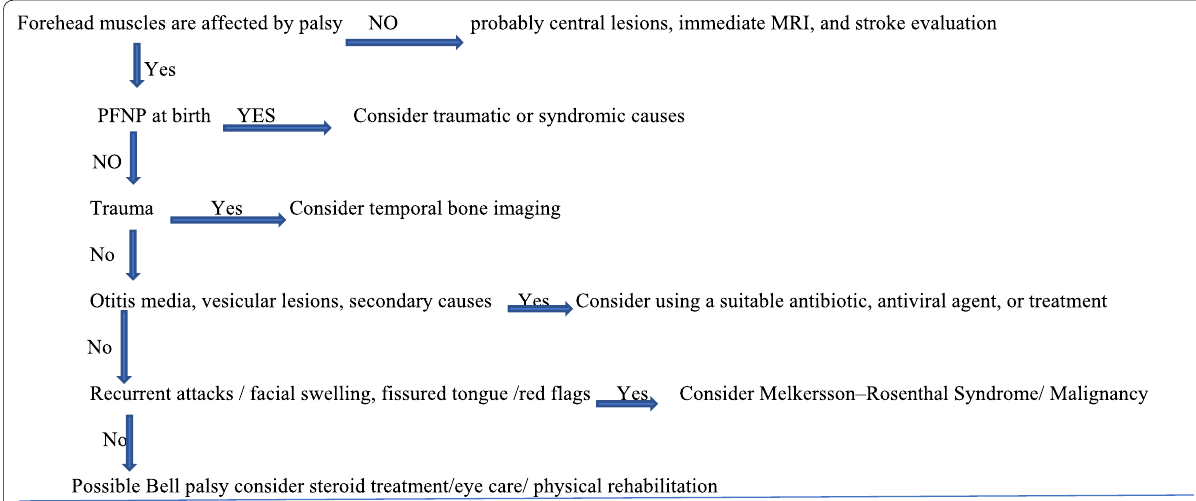
Fig. 1 Algorithm for aid in diagnosing children with facial nerve